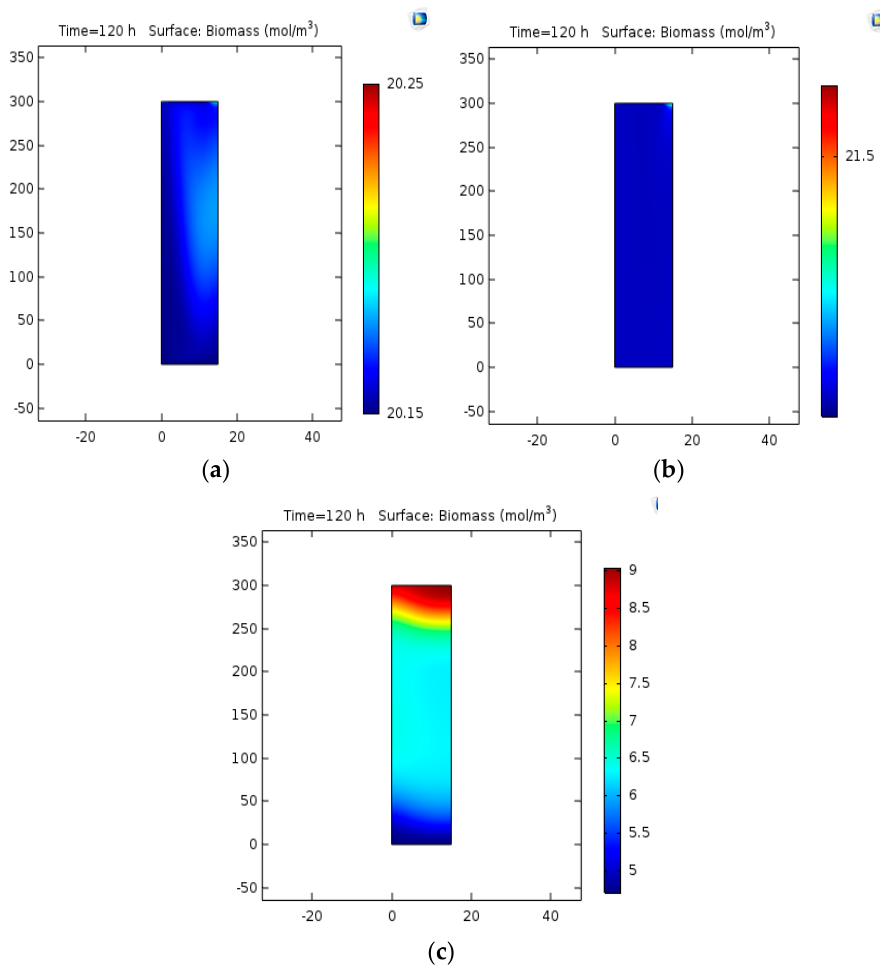
Figure 8. ( a ) Biomass concentration at the gas velocity of 0.0015 m/s, ( b ) biomass concentration at the gas velocity of 0.065 m/s, ( c ) biomass concentration at the gas velocity of 0.15 m/s.